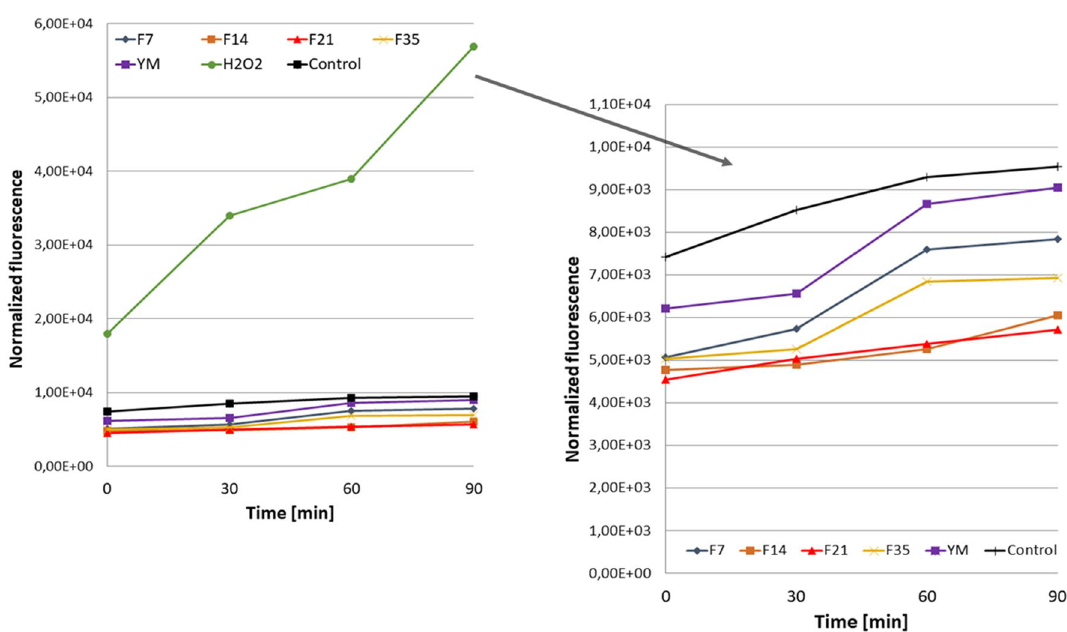
Figure 5. Effect of Yerba Mate and Kombucha ferments (at a concentration of 250 µg/mL) on the DCF fluorescence in HaCaT cells. Data are expressed as the mean of 3 independent experiments each consisting of three replicates per treatment